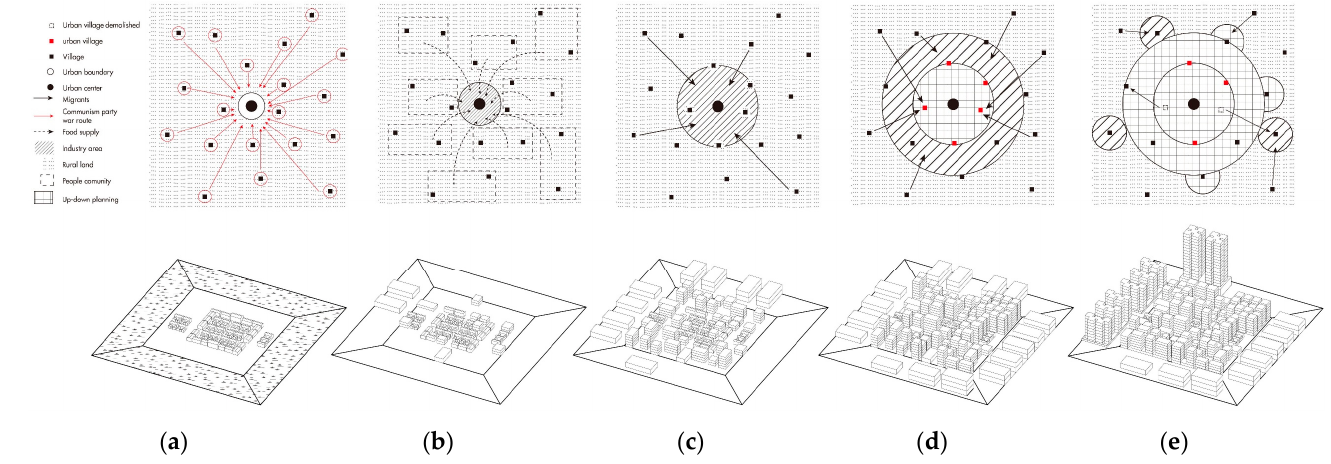
Figure 1. The Development Process of Urban Village: ( a ) Traditional village: city scale and block scale; ( b ) Village of People’s Commune: city scale and block scale; ( c ) Village included inside the city: city scale and block scale; ( d ) Densified Village: city scale and block scale; ( e ) Intensified Village: city scale and block scale.